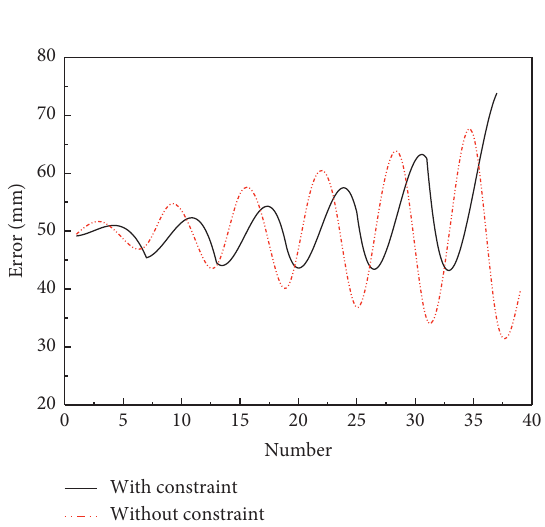
With constraint Without Figure 4: Comparison of algorithm-bound particle data and number of